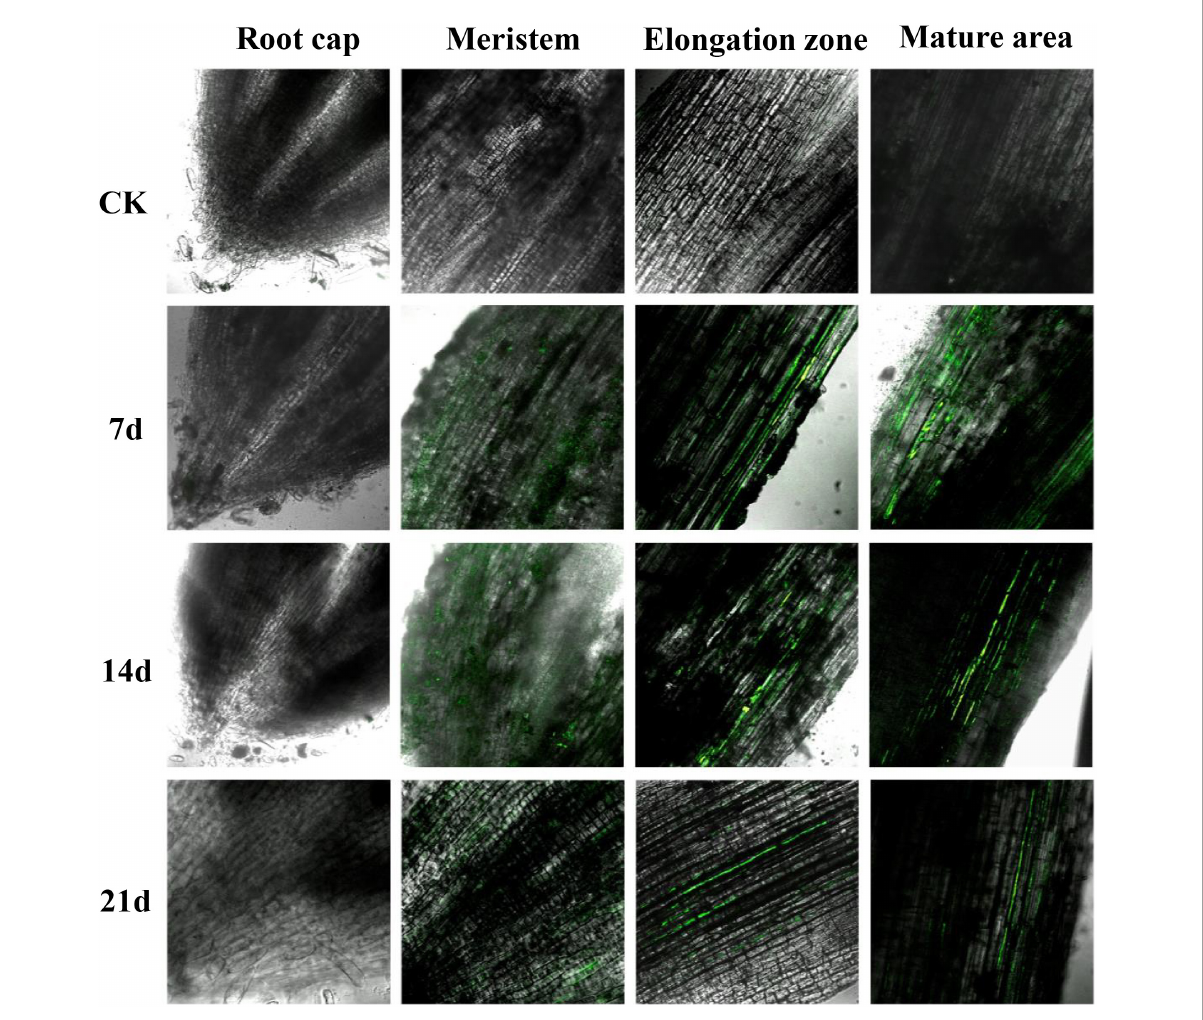
FIGURE6 Confocal laser scanning microscope (CLSM) photos of strain Za- gfp in solid agents colonized on the root surface of maize seedlings. The experimental materials were obtained from the maize seedling samples of the CK and J groups (solid